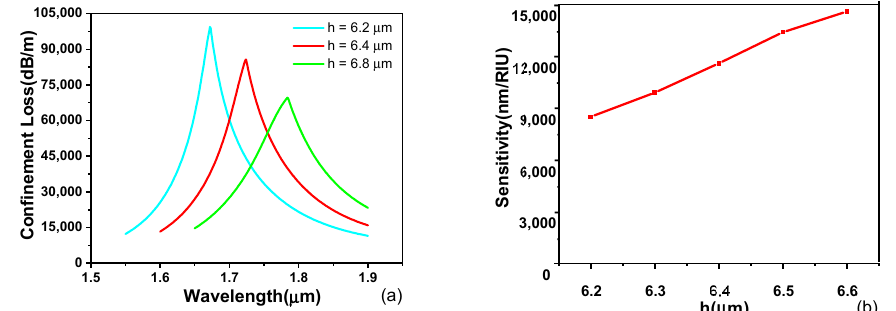
Figure 7. The loss spectrum ( a ) and sensitivity ( b ) for different core-to-surface interval h. The remaining parameters are d = 1.6 μ m, d 2 = 1 μ m, t ITO = 60 nm, and n a = 1.38.